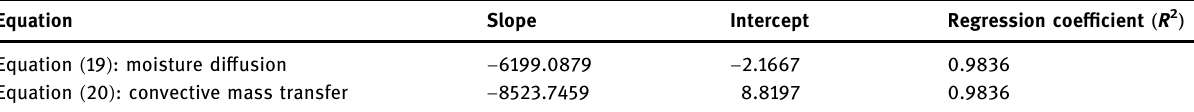
Table 4: Parameters for linearization of equations ( 19 ) and ( 20 ) , respectively, for ln ( D e ) and ln ( h m ) for the drying of thistle fl ower Equation Slope Equation ( 19 ) : moisture di ff usion